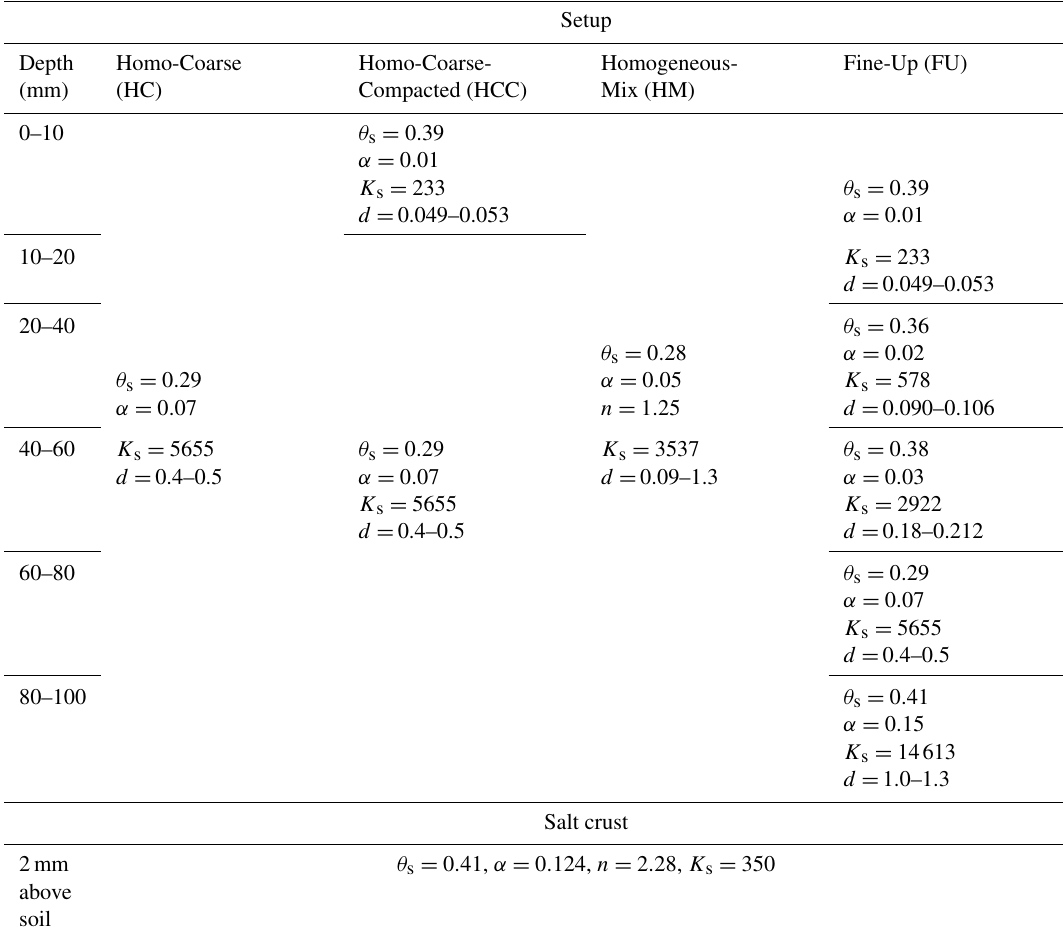
Table 1. Hydraulic parameters of the modeled setups. Symbols θ s , α , K s , and d stand for water content at saturation (cm 3 cm − 3 ), the α van Genuchten parameter (cm − 1 ), hydraulic conductivity at saturation (cmd − 1 ), and range of particle diameters (mm), respectively. Where not mentioned, the n van Genuchten parameter is equal to 3 (unitless). For all simulations, the tortuosity parameter in the conductivity function was taken to be equal to 0.5